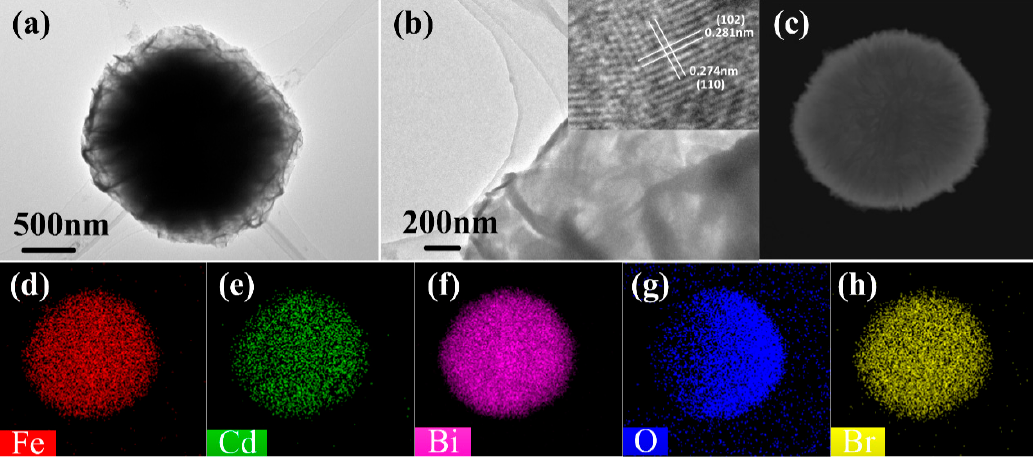
Figure 3. TEM image of Bi 1 − x − y Cd x Fe y OBr ( a ); HRTEM image of Bi 1 − x − y Cd x Fe y OBr ( b ) and corresponding elemental mappings of Bi 1 − x − y Cd x Fe y OBr ( c – h ).